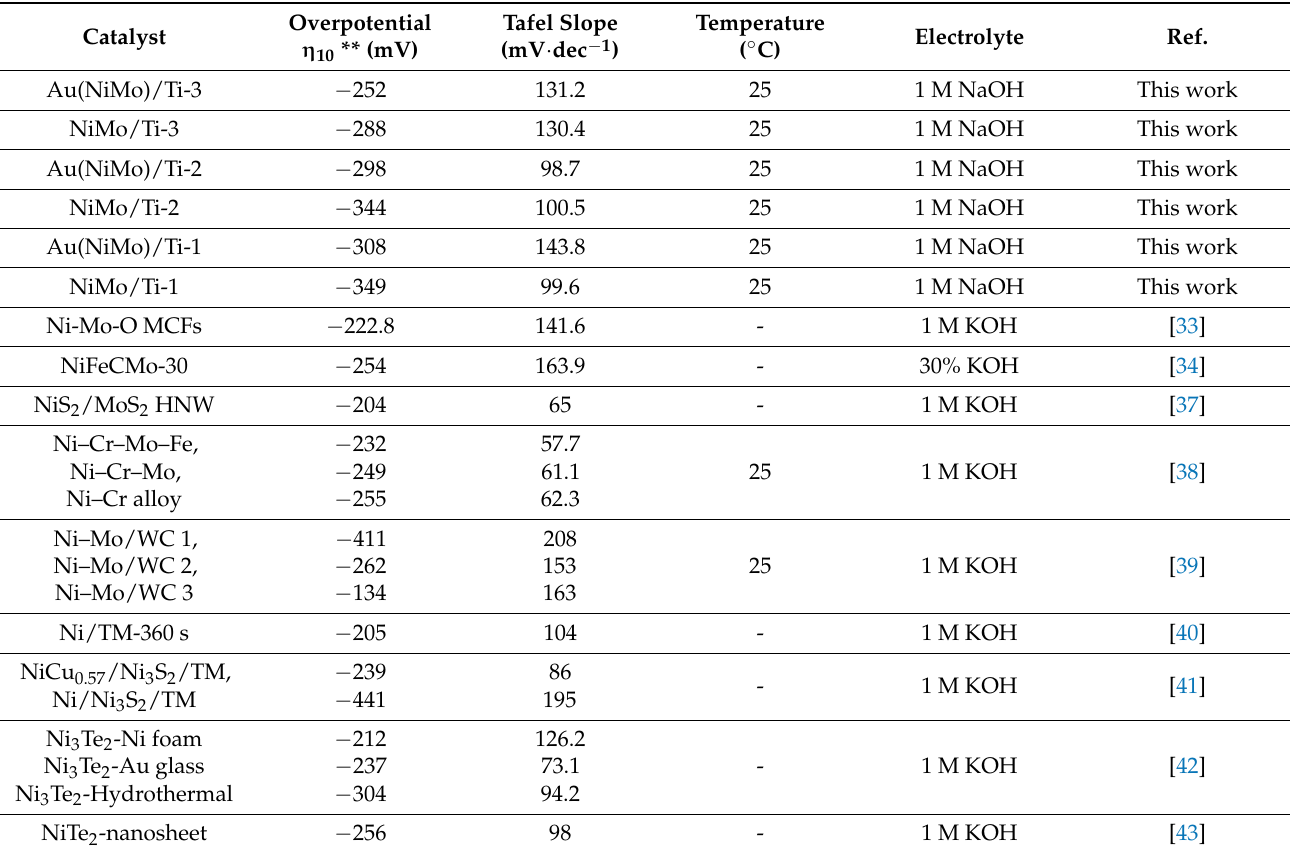
Figure 5. Chronoamperometric data of the investigated NiMo/Ti and Au(NiMo)/Ti catalysts in 1 M NaOH solution at the potential value of − 0.22V (vs. RHE), t = 2 h. A comparison of HER parameters generated using herein-tested NiMo/Ti and Au(NiMo)/Ti catalysts in an alkaline medium with some electrodes reported in the litera- ture is given in Table 4. Table 4. The electrochemical performance of herein tested catalysts towards HER in alkaline media and compared with that of transition metal-based electrodes reported in the literature.